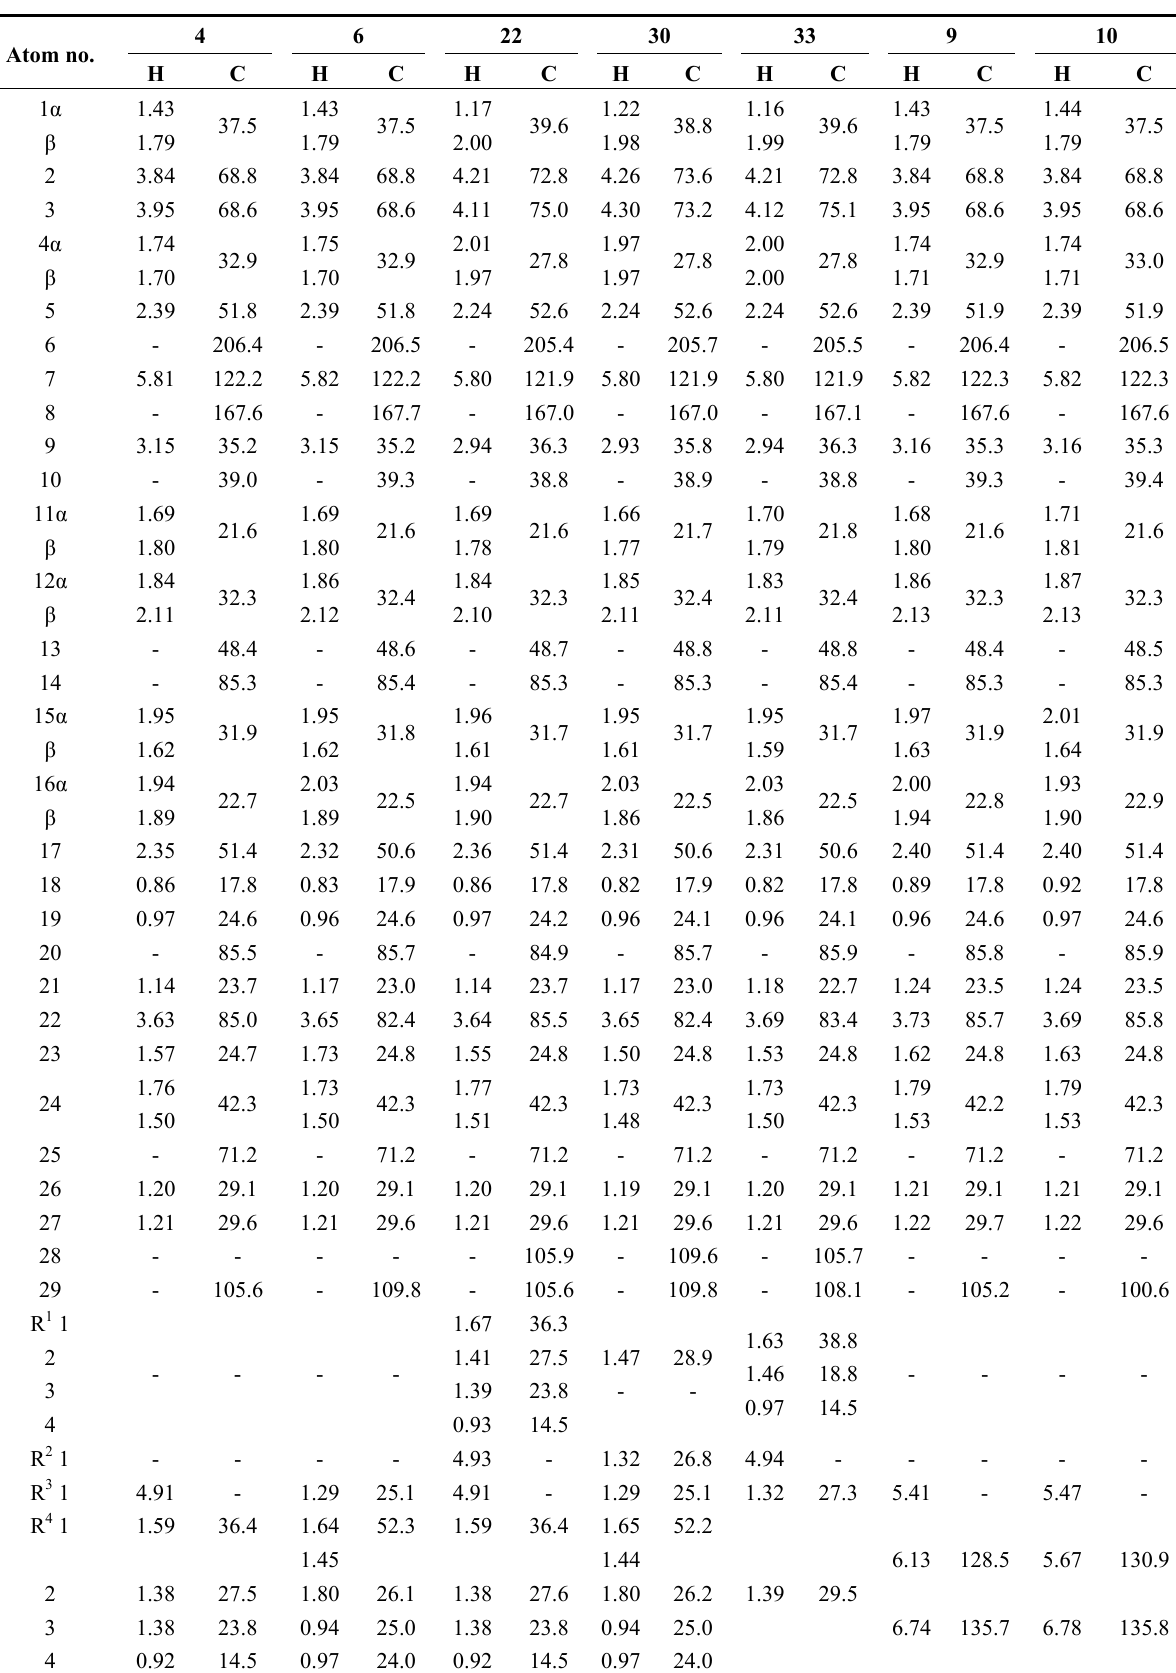
Table 1. 1 H- and 13 C-NMR shifts of compounds 4 , 6 , 22 , 30 , 33 , 9 and 10 ; in ppm, in methanol- d 4